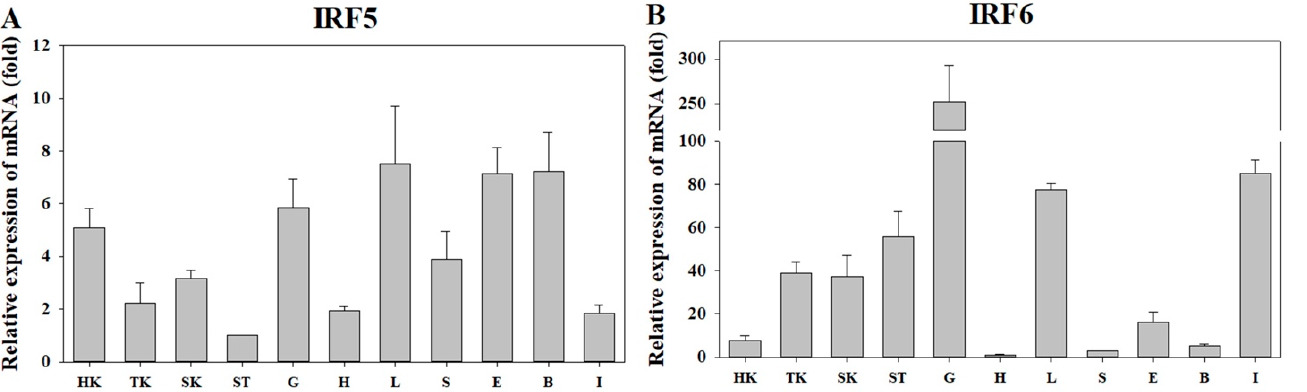
Figure 3. Distribution of ( A ) IRF5 and ( B ) IRF6 mRNA expression related to EF-1 α expression in red sea bream organs (exhibited relative to the organ with the lowest mRNA expression level). The 11 organs are the head kidneys (HK), trunk kidneys (TK), skin (SK), stomach (ST), gills (G), liver (L), heart (H), spleen (S), eyes (E), brain (B), and intestine (I). Results exhibit the mean ± SD of triplicate ( n = 3).